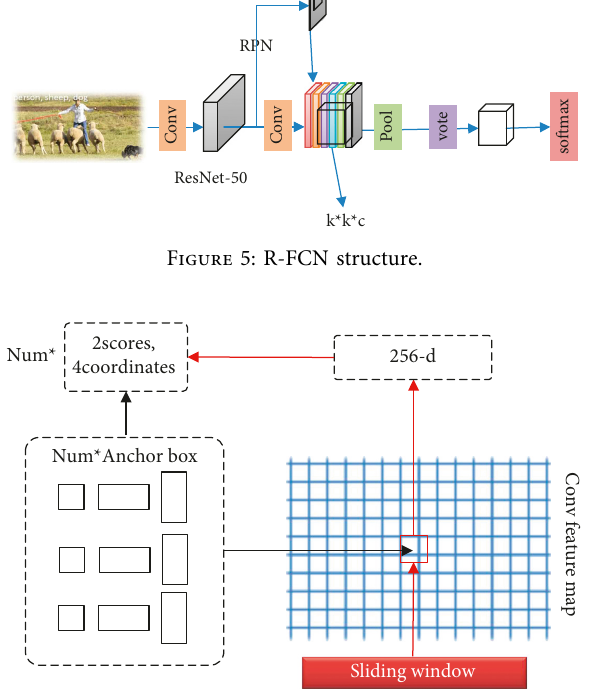
Figure 6: Regional proposal network structure diagram.